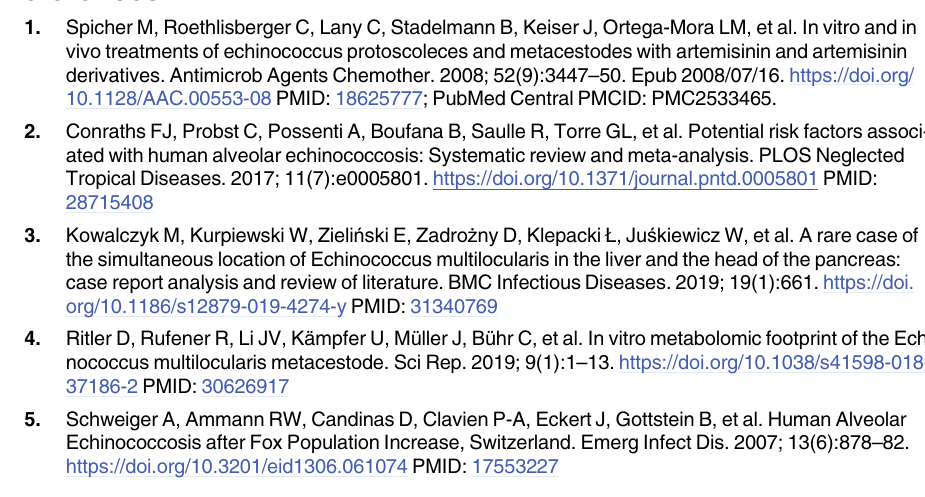
S4 Fig. E . multilocularis infection does not affect miR-15a-5p, miR-148a-3p, miR-22-3p, miR-30a-3p and miR-30a-5p expression levels. miR-15a-5p, miR-148a-3p, miR-22-3p, miR- 30a-5p and miR-30a-3p levels, in mock-infected, mock-treated mice (CTRL locularis infected mock-treated mice (AE n = 6 ). Results represent mean ± SD. No outliers were excluded. Two-tailed unpaired t-test was applied to test significance. (TIF) S1 File. Raw data of Western blotting used to produce graphs and figures.